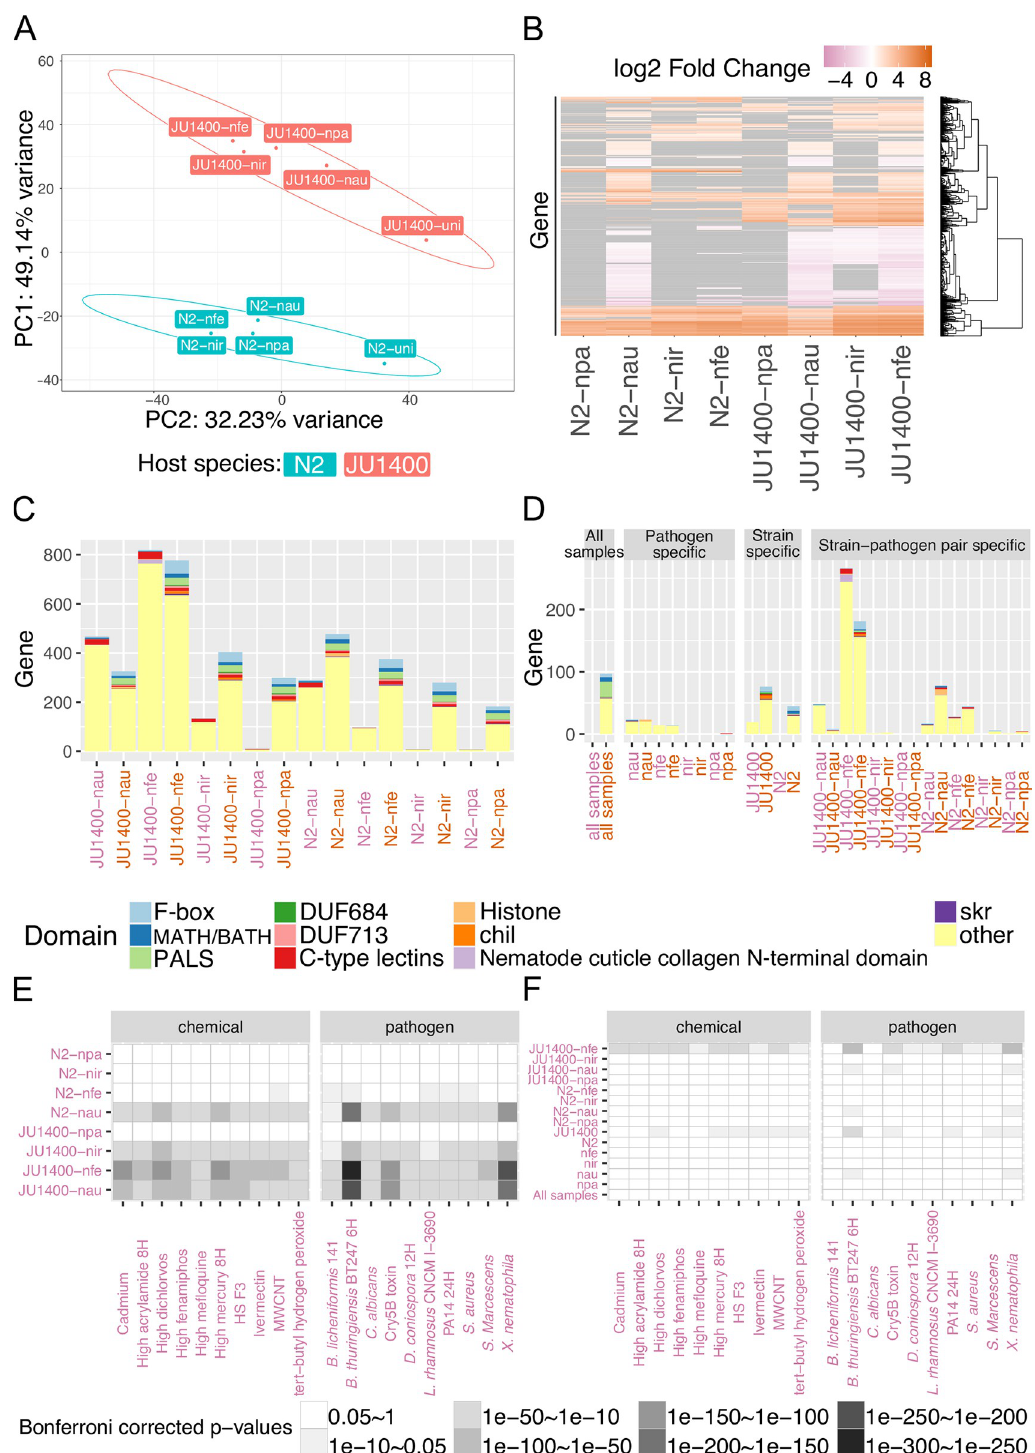
Fig 7. RNA-seq analysis of N2 and JU1400 infected with four species of microsporidia. N2 and JU1400 animals were infected with one of four species of microsporidia (see Methods for doses) for 48 hours and RNA was extracted and sequenced. (A) Principal component analysis of uninfected and infected N2 and JU1400 samples. Circles represent confidence ellipses around each strain at 95% confidence interval. (B) Heatmap of transcriptional profiles of differentially regulated genes in N2 and JU1400 samples. Rows represent genes clustered hierarchically. Scale is of differential regulation of infected compared to